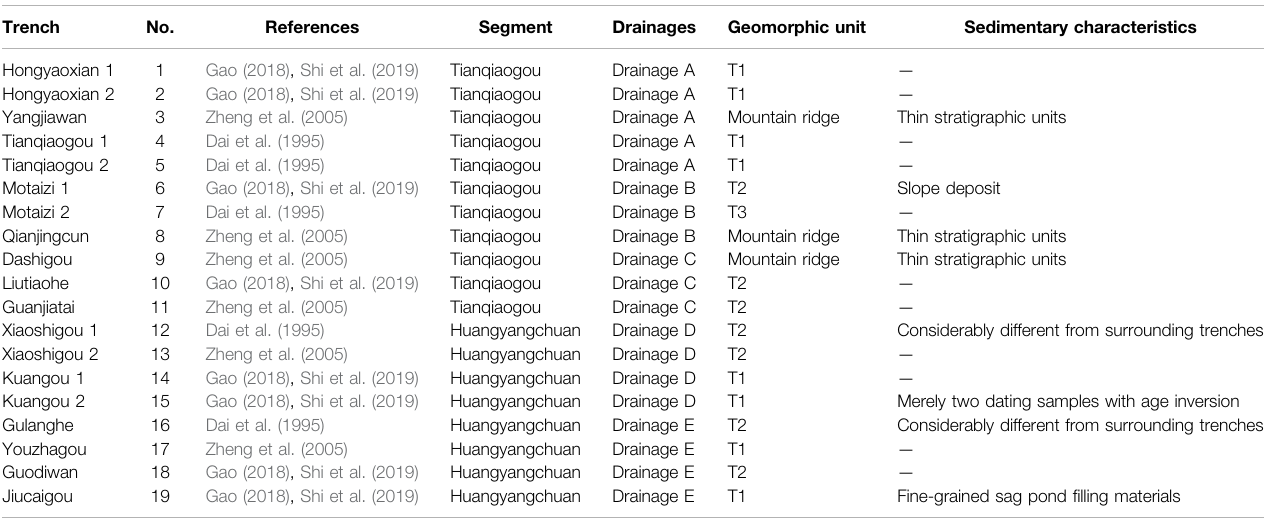
TABLE 1 | Trenches: locations, geomorphic units, and sedimentary characteristics.